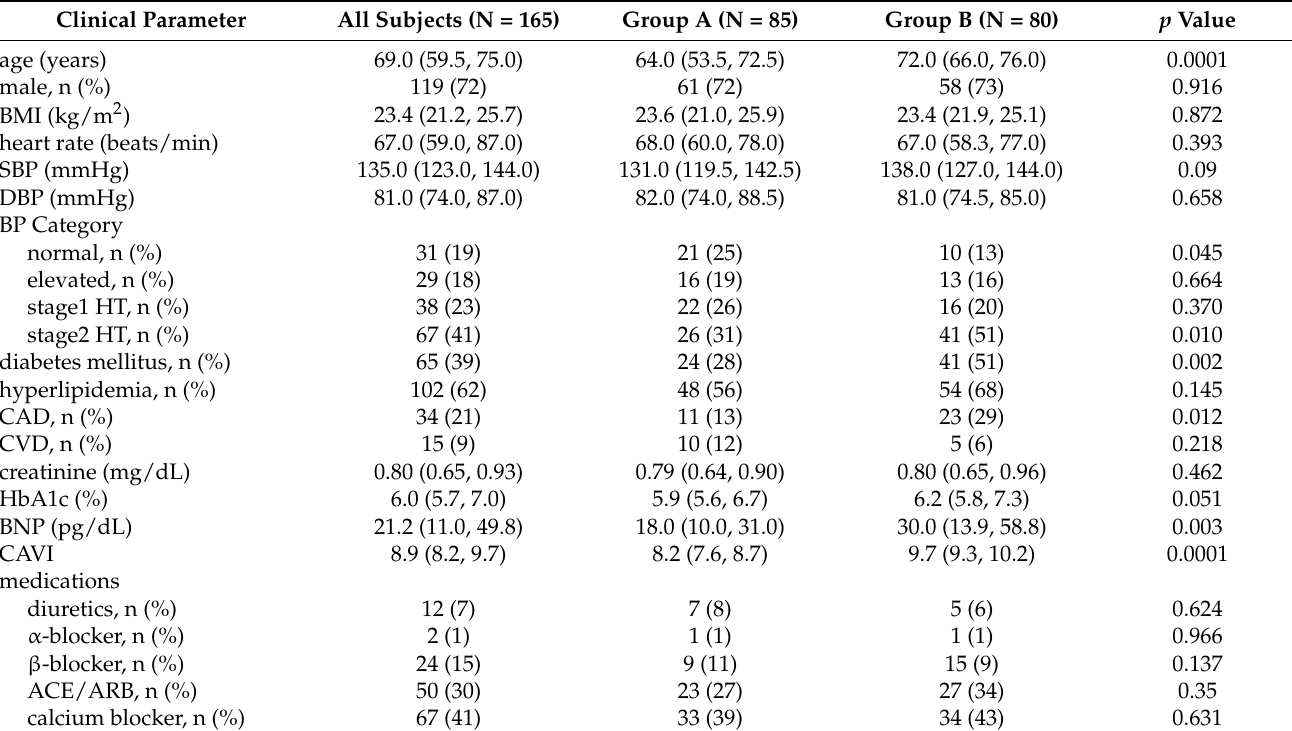
Table 1. Comparison of the clinical characteristics according to the CAVI